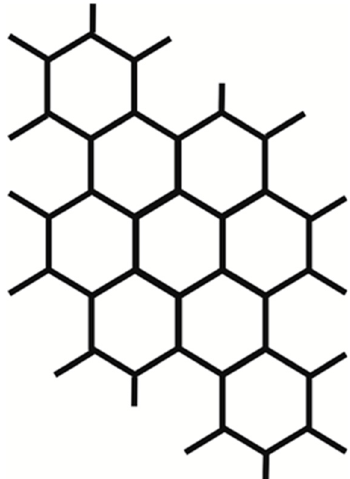
Figure 2. Schematic representation of the thiourea molecule.